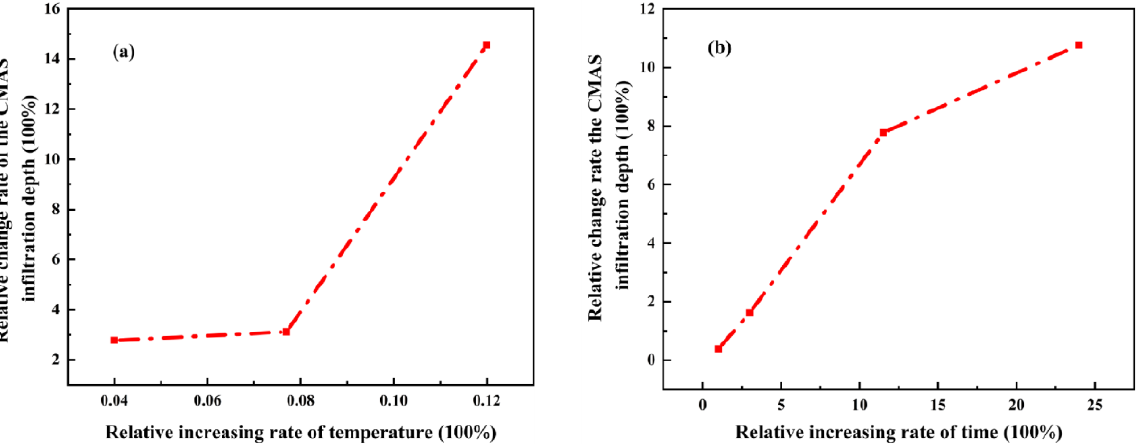
Figure 15. Relative change rates of the CMAS infiltration depth with the relative increasing rates of temperature ( a ) and time ( b ).